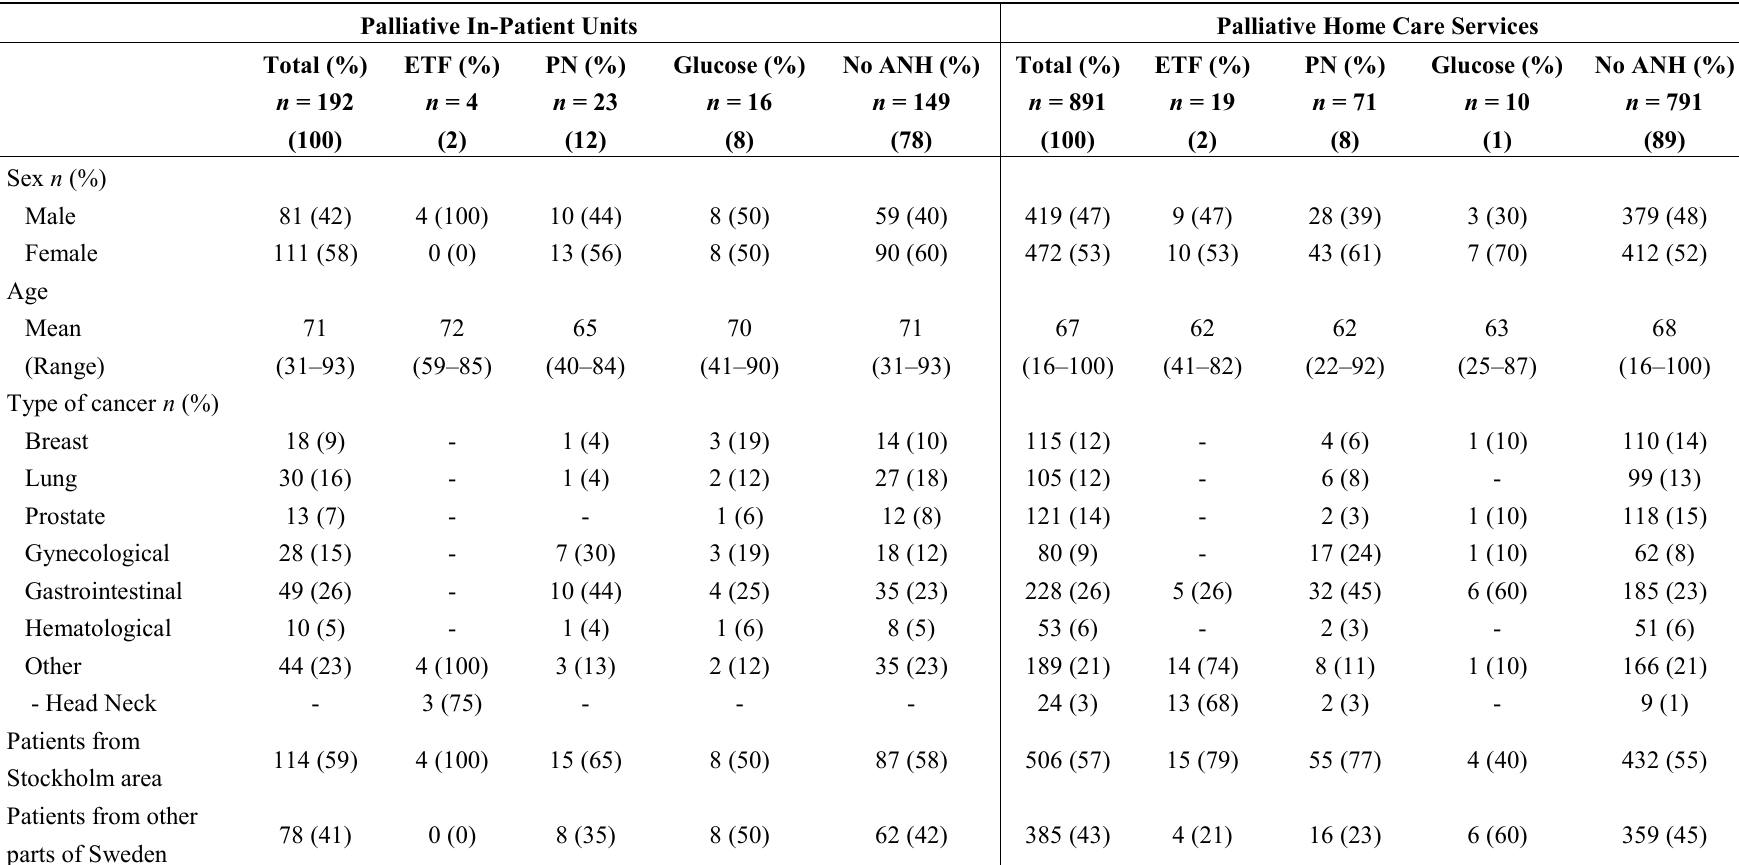
Table 1. Characteristics of patients by palliative care setting and use of enteral tube feeding, parenteral nutrition and intravenous glucose ( n = 1083). Palliative In-Patient Units Palliative Home Care